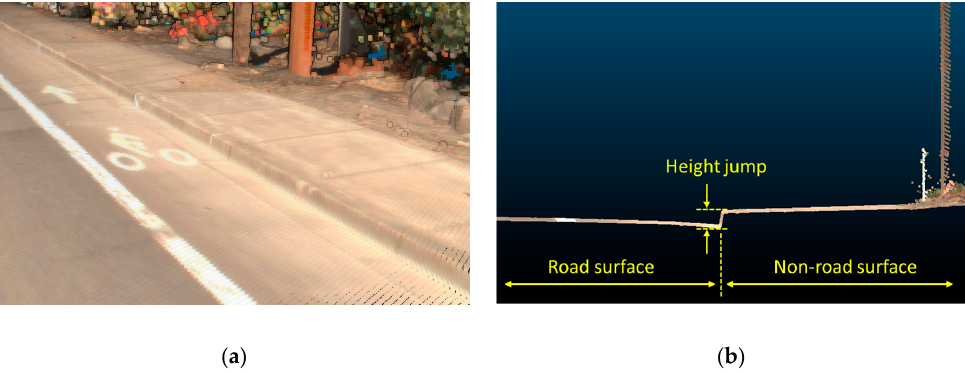
Figure 4. Example of height jump along the road boundary: ( a ) in 3D view and ( b ) in profile view.